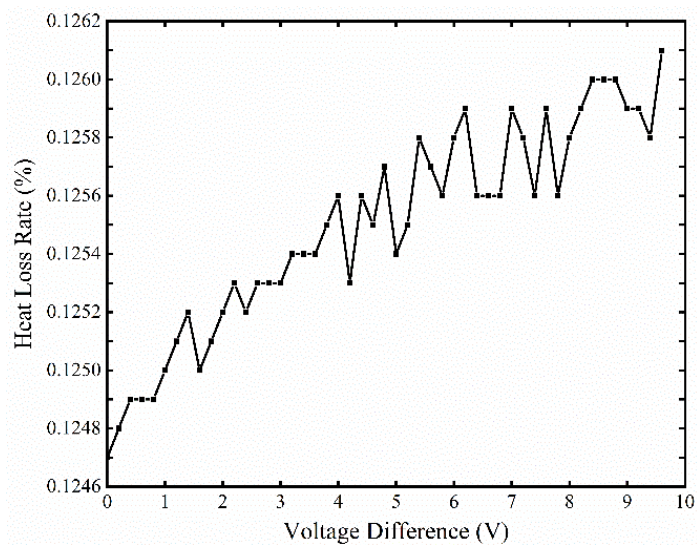
Figure 15. Variation of heat loss rate with voltage difference.